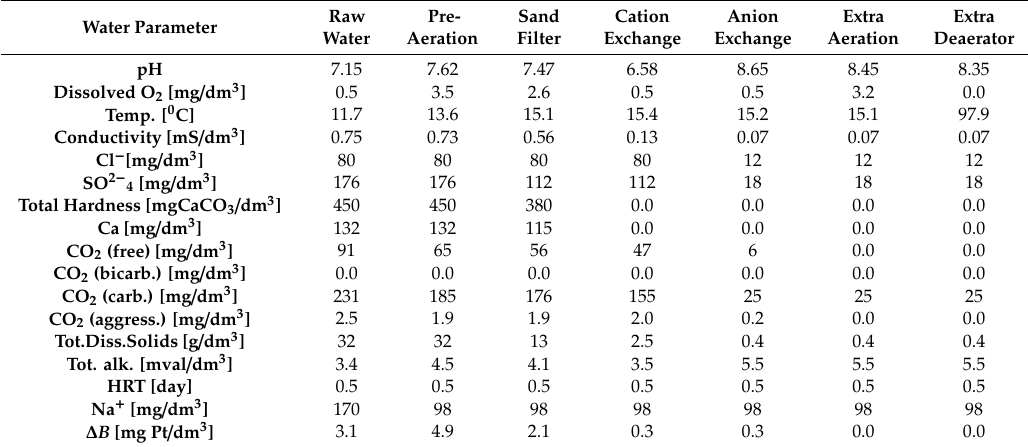
Table 1. Parameters of water pollution after successive treatment steps. HRT, hydraulic retention